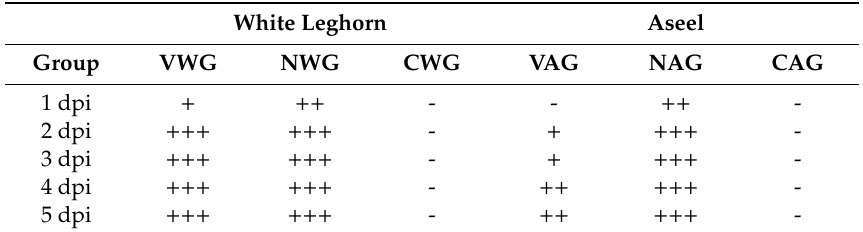
Figure 3. ( a ) Harderian gland of VWG showing hyperemia at 1 dpi. ( b ) HG of NWG showing hyperemia, necrosis and mild depletion of plasma cells (arrows) at 2 dpi. ( c ) HG of control birds densely populated with plasma cells H&E X400. Table 4. Immunohistochemical scoring of bursal sections in di ff erent groups of WLH and Aseel birds at di ff erent intervals of time.